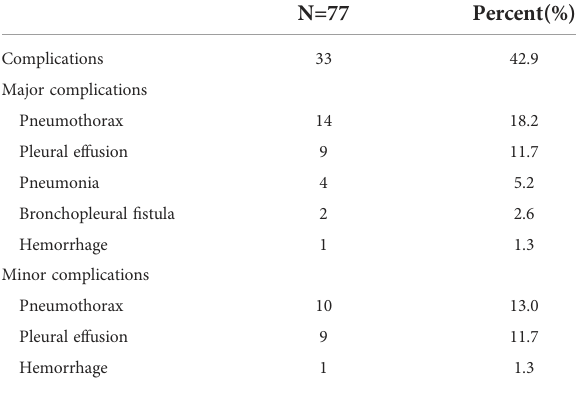
TABLE 6 The complications of microwave ablation.